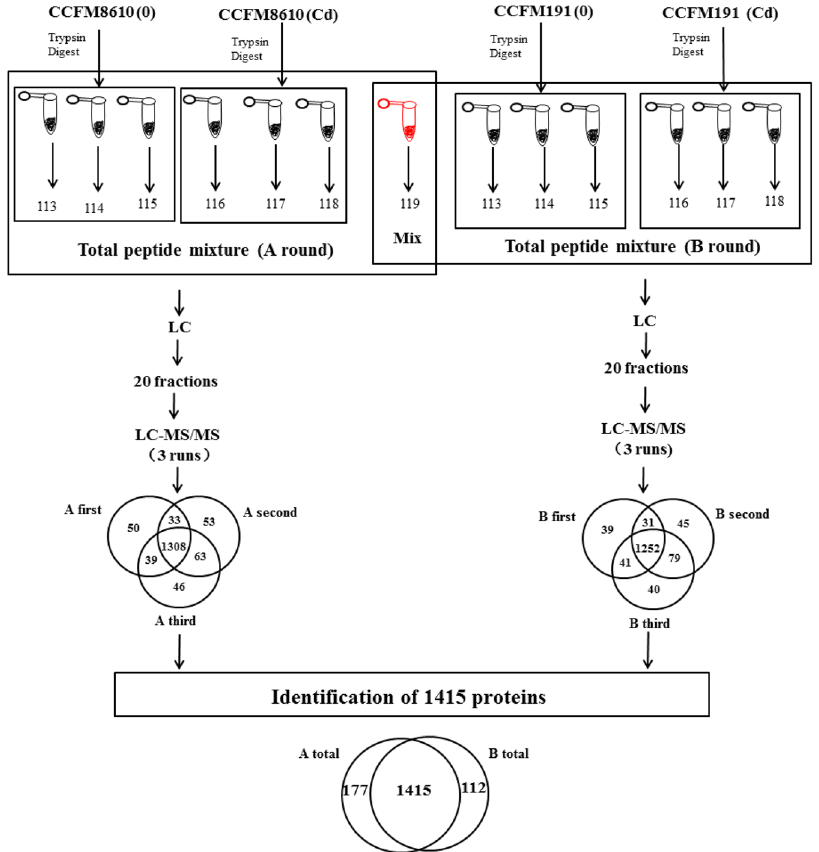
Figure 2. Workflow of iTRAQ experiment.